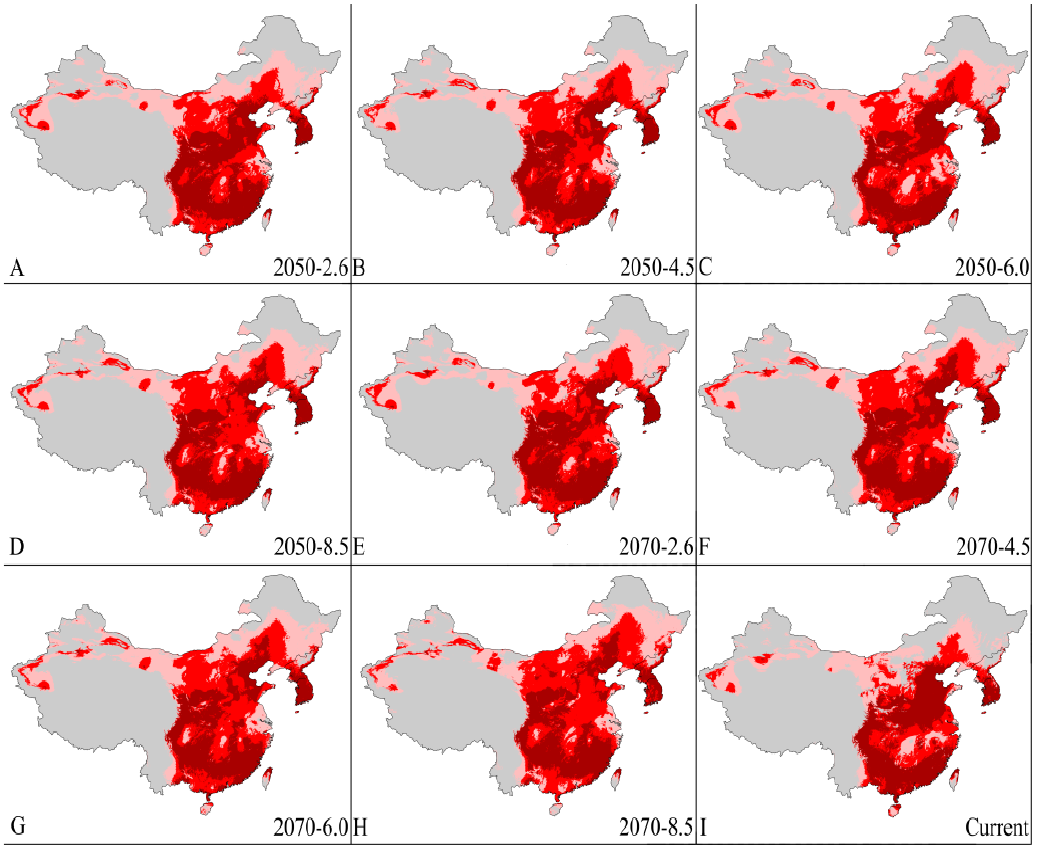
Figure 8. Future potential suitable habitats of Pseudaulacaspis pentagona on China and Korean Peninsula under different climate scenarios predicated by MaxEnt. Gray, unsuitable habitat area; Pale red, low habitat suitability area; Red, moderate habitat suitability area; Dark red, high habitat suitability area. ( A ) RCP 2050-2.6; ( B ) RCP 2050-4.5; ( C ) RCP 2050-6.0; ( D ) RCP 2050-8.5; ( E ) RCP 2070-2.6; ( F ) RCP 2070-4.5; ( G ) RCP 2070-6.0; ( H ) RCP 2070-8.5; ( I ) Current.